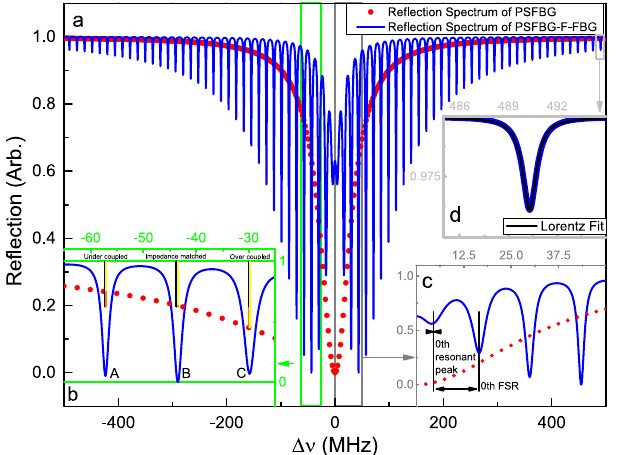
Figure 2. Theoretical spectrum reflection of 7.3 m long PSFBG-F-FBG resonator, plotted versus the frequency detuning Δ v = C / λ − C / λ B : ( a ) comparison of PSFBG-F-FBG resonator reflection spectrum (blue solid curve) and single phase-shifted grating reflection spectrum (red dot curve), ( b ) enlargement of green block in ( a ), with a description of impedance matching situations for points A, B and C, ( c ) enlargement of gray block in ( a ), with a description of resonant peak index number and free spectral range index number, ( d ) enlargement of light gray block in ( a ), with a Lorentz fit of single resonant peak.